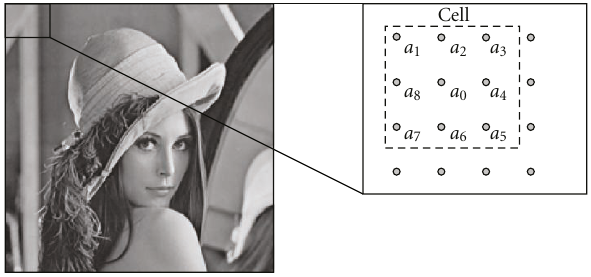
Figure 2: A cell for the proposed scheme.